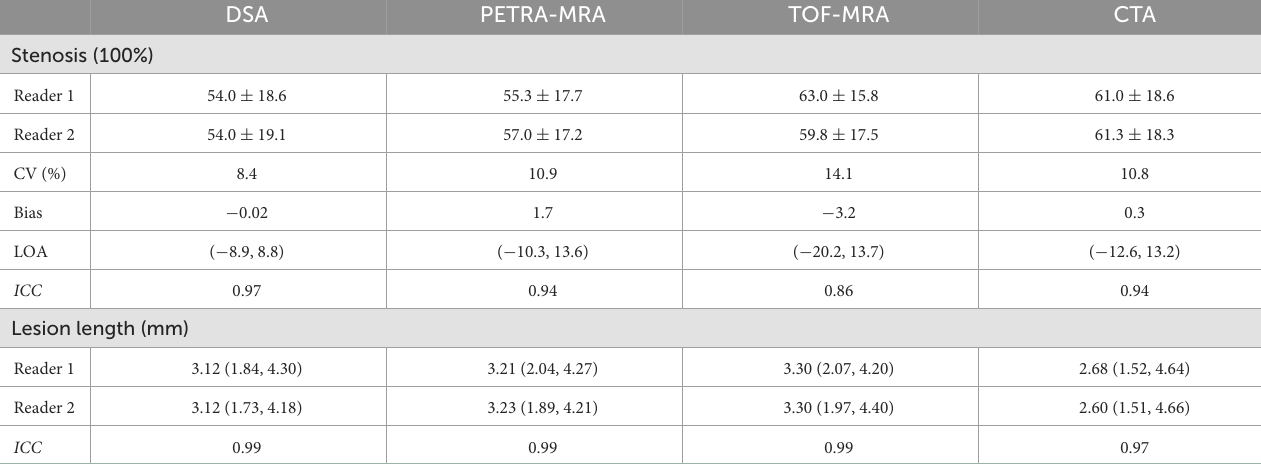
TABLE 4 Comparison of MRAs/CTA and DSA in measuring the degree of stenosis and lesion length. DSA PETRA-MRA TOF-MRA